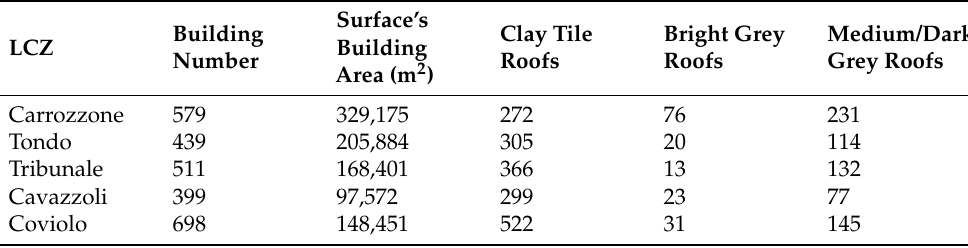
Table 5. Different kinds of building roofs retrieved by WV3 classification.